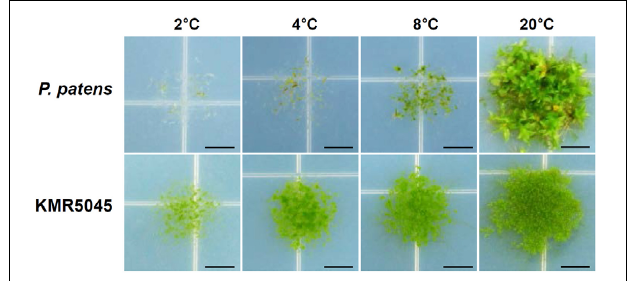
FIGURE 2 | Comparison of growth responses of P. patens and KMR5045 under low-temperature conditions. Protonema tissues were inoculated onto fresh Knop medium and then grown at 2, 4, 8, and 20 ◦ C for 5 weeks before photographs were taken. Scale bars = 5